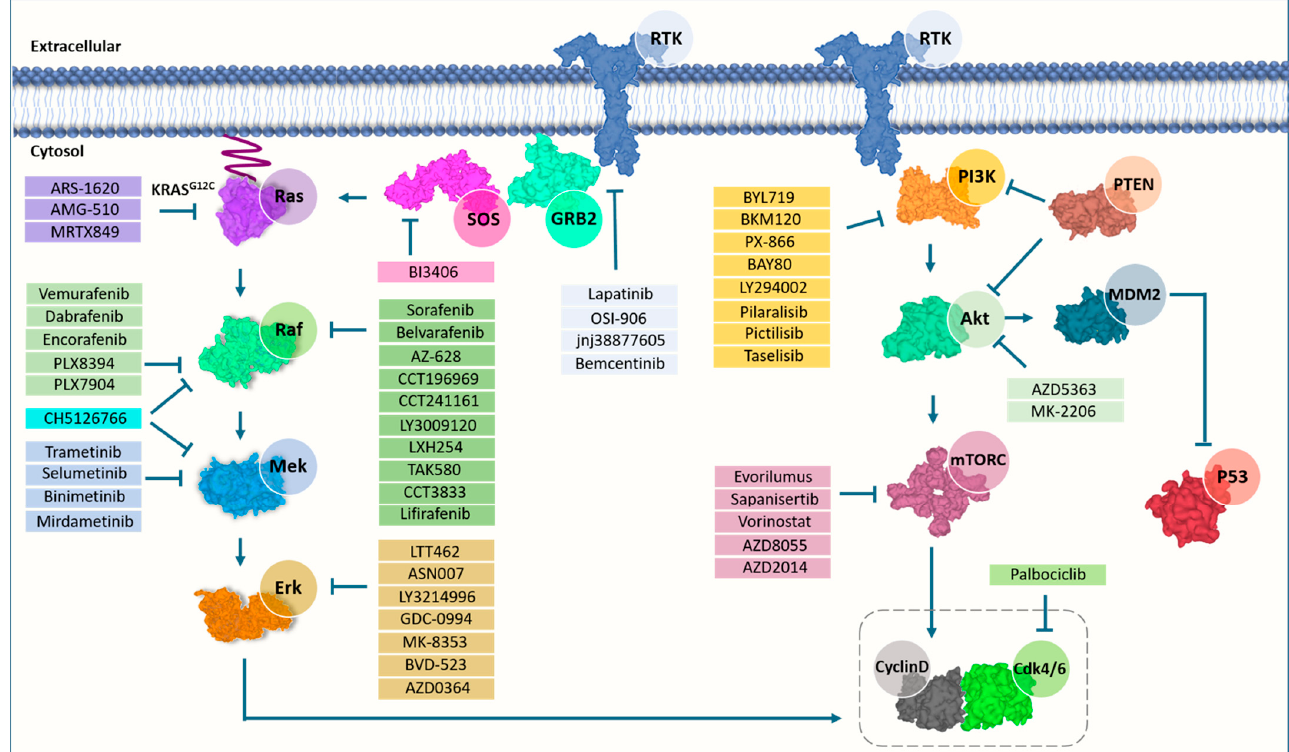
Figure 2. Inhibitors targeting rat sarcoma virus (RAS) effector pathways. Tumor radio-resistance remains a major obstacle for the treatment of many types of cancer. Both MAPK and PI3K-mTOR pathways have been implicated with radio-resistance of RAS-dependent cancer cells [175,176]. Clinical data show that most cancer patients bearing KRAS mutations have a higher frequency of metastasis and recurrence of disease following radiotherapy [177]. Activation of the PI3K-Akt pathway has been shown to enable the repair of double-stranded breaks formed by radiotherapy through the induction of DNA-PKcs in cancer cells [178–180]. Akt-1 directly binds to DNA-PKcs and promotes its activity to initiate the NHEJ repair pathway, thereby resulting in the resistance to radiotherapy. Further, it has been shown that PI3K inhibition stimulates sufficient to sensitize KRAS-mutant NSCLC cells to irradiation. Correspondingly, dual targeting of PI3K and MEK efficiently improved radio-sensitization through the blockade of Akt reactivation and impairment of DSBs repair [181]. In a phase Ib dose-escalation study, a highly selective pan-PI3K inhibitor, buparlisib, in combination with the MEK1/2 inhibitor trametinib, represented promising anti-tumor activity in patients with KRAS-